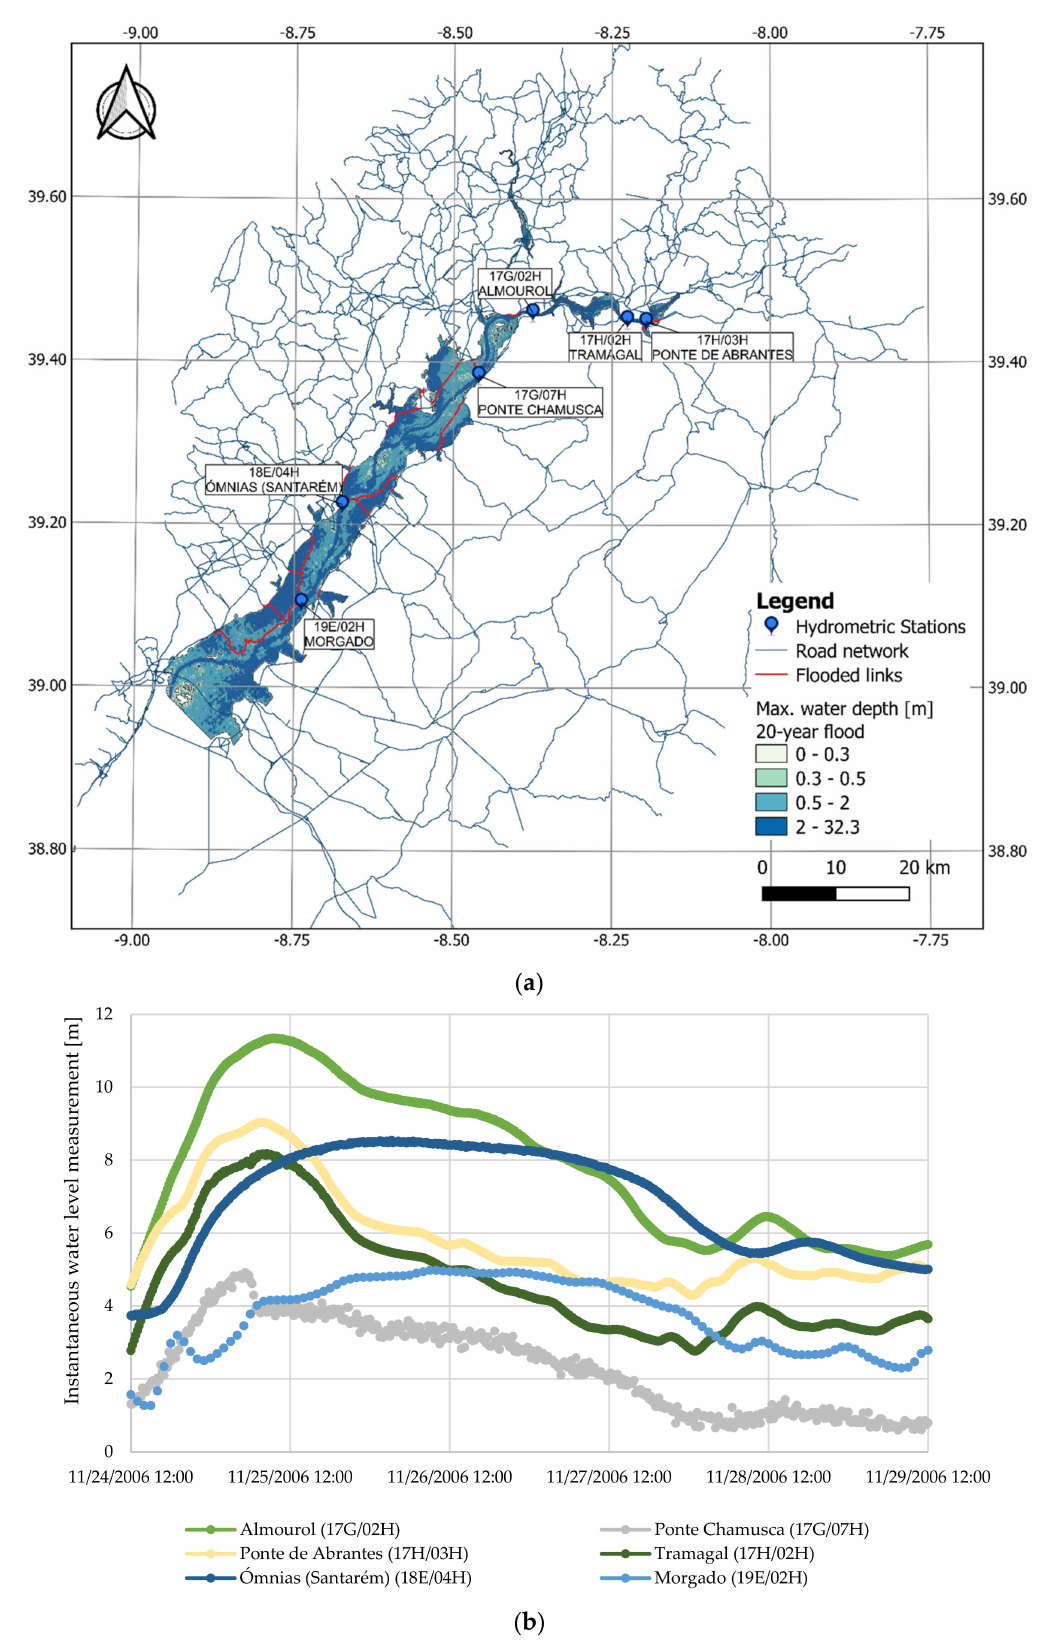
Figure 4. ( a ) Overlapping of the roadway network with water-depth map for a 20-year return period flood; ( b ) Instantaneous water level measurements at each hydrometric station (in